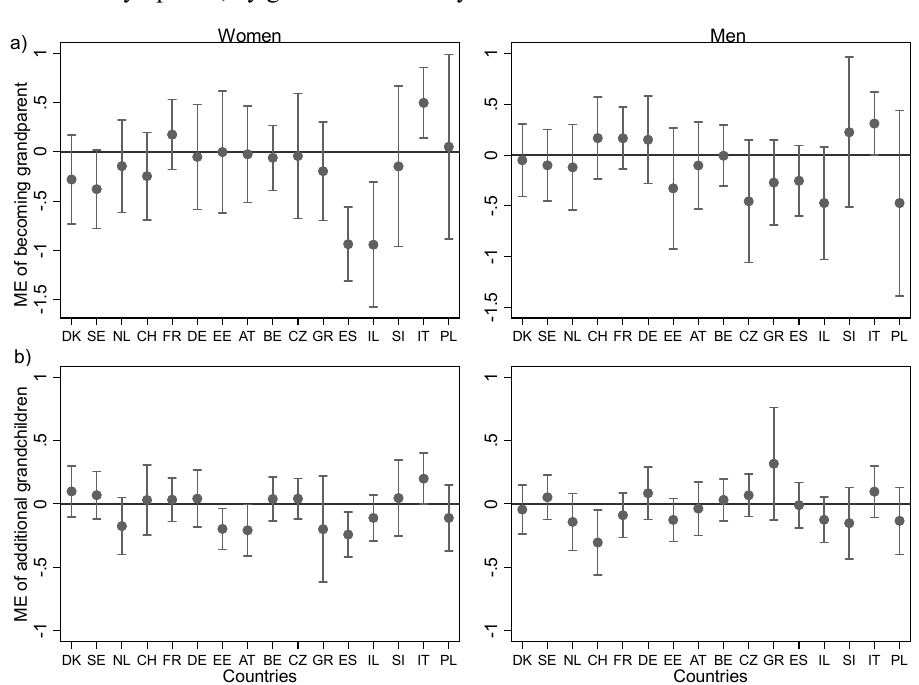
Figure 1 : Marginal effects (ME) from fixed-effects models for the effect of a) becoming a grandparent and b) having additional grandchildren on depressive symptoms, by gender and